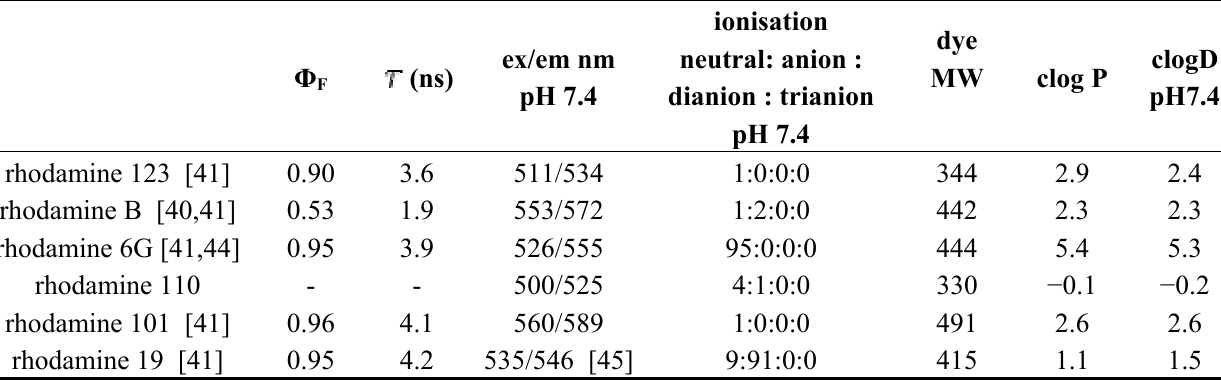
Table 8. Physicochemical properties of rhodamine